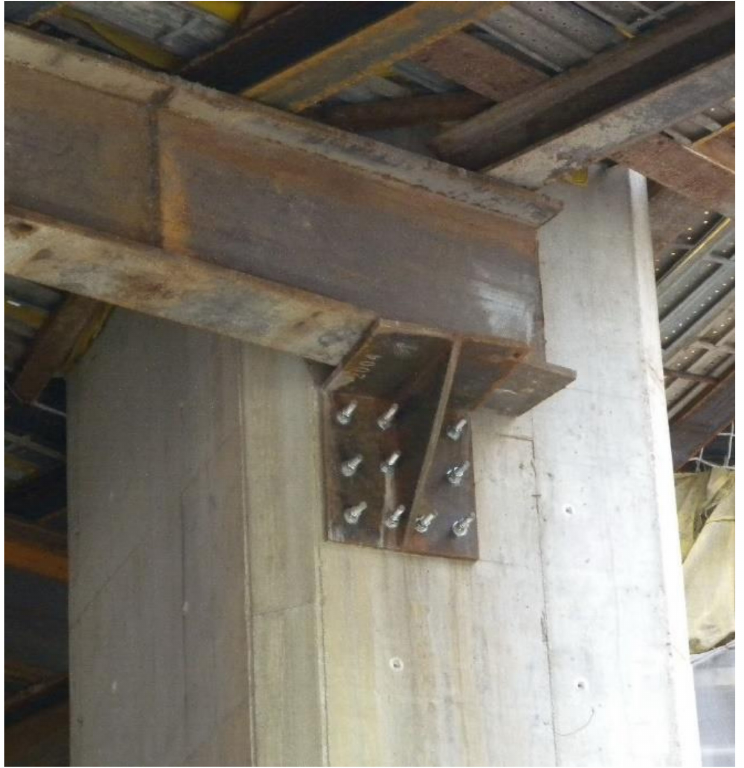
Figure 1. Using an anchorage to fasten the support element of a steel beam to the reinforced concrete bearing structures of a building.